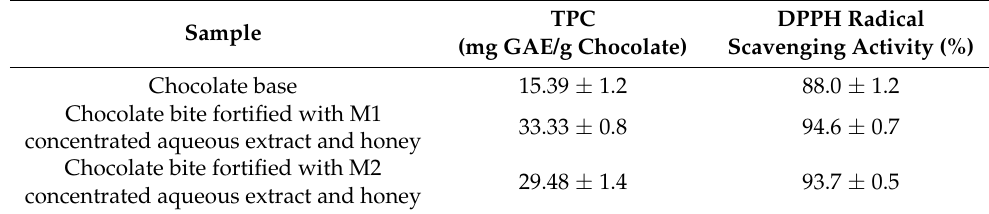
Figure 1. Total phenolic content (TPC) and DPPH radical scavenging activity of medicinal aromatic plant (MAP) concentrated aqueous extracts in the presence of erythritol or honey. In each M1 and M2 concentrated aqueous extract obtained with honey, a chocolate base was added to produce sugar-free biofunctional chocolate bites. The TPC and DPPH radical scavenging activity of the chocolate bites produced were assessed and compared to the TPC and DPPH radical scavenging activity of the chocolate base. The results are presented in Table 2. Table 2. TPC and DPPH radical scavenging activity of chocolate base and chocolate bites fortified with M1 or M2 concentrated aqueous extracts and